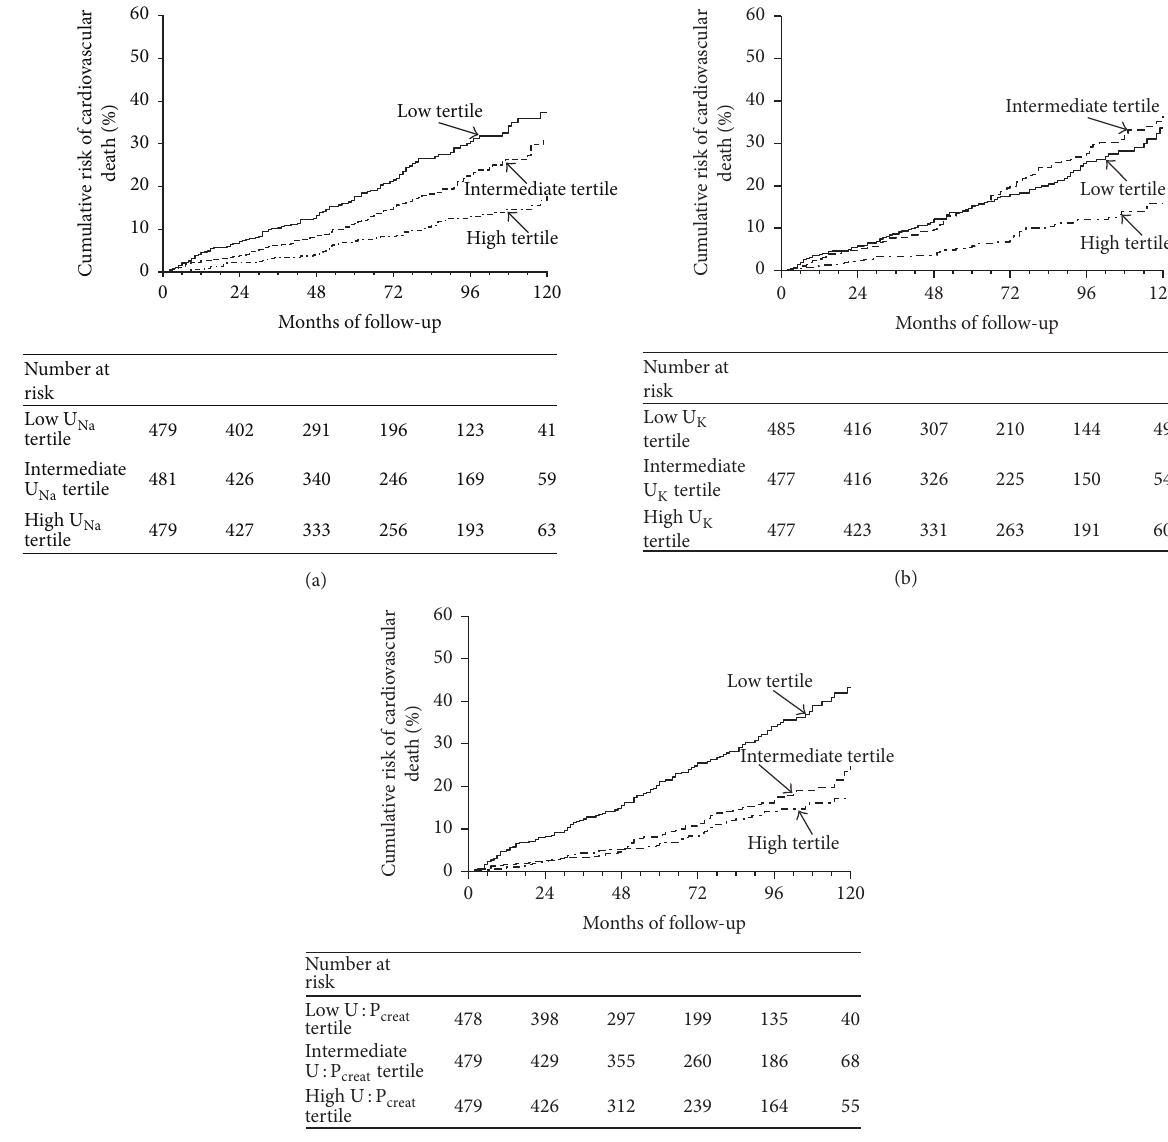
Figure 2: Cumulative risk of cardiovascular death according to urinary solute tertiles. (a) Kaplan-Meier survival curves are displayed ) at baseline. Patient grouping: solid line indicates high U tertile patients; dashed according to tertiles of urinary sodium concentration (U Na Na tertile patients; grey line indicates low U tertile patients. P value Log-rank test < 0.001. (b) Kaplan-Meier line indicates intermediate U Na Na ) at baseline. Patient grouping: solid line indicates survival curves are displayed according tertiles of urinary potassium concentrations (U K tertile patients; dashed line indicates intermediate U tertile patients; dotted line indicates low U tertile patients. 𝑃 value Log-rank high U K K K ) at test < 0.001. (c) Kaplan-Meier survival curves are displayed according to tertiles of urine to plasma creatinine concentration ratio (U: P creat tertile patients; dashed line indicates intermediate U: P tertile patients; dotted baseline. Patient grouping: solid line indicates high U: P creat creat tertile patients. 𝑃 value Log-rank test < line indicates low U :P creat